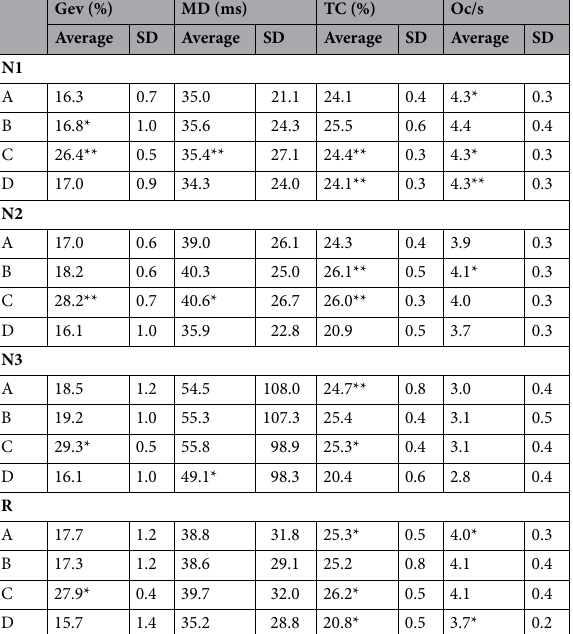
Table 1. Microstate parameters of 4 microstates in controls in 4 sleep stages. The stars indicate the significant difference at each sleep stage between controls and OSA-OH patients (*P < 0.05, **P < 0.01).